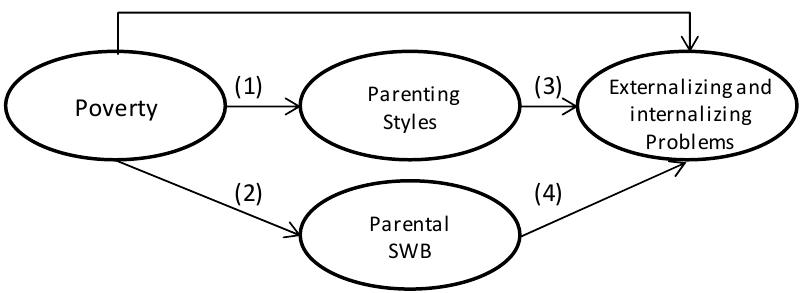
Figure 1. Pathways from poverty to child behavioral problems. SWB: subjective well-being.